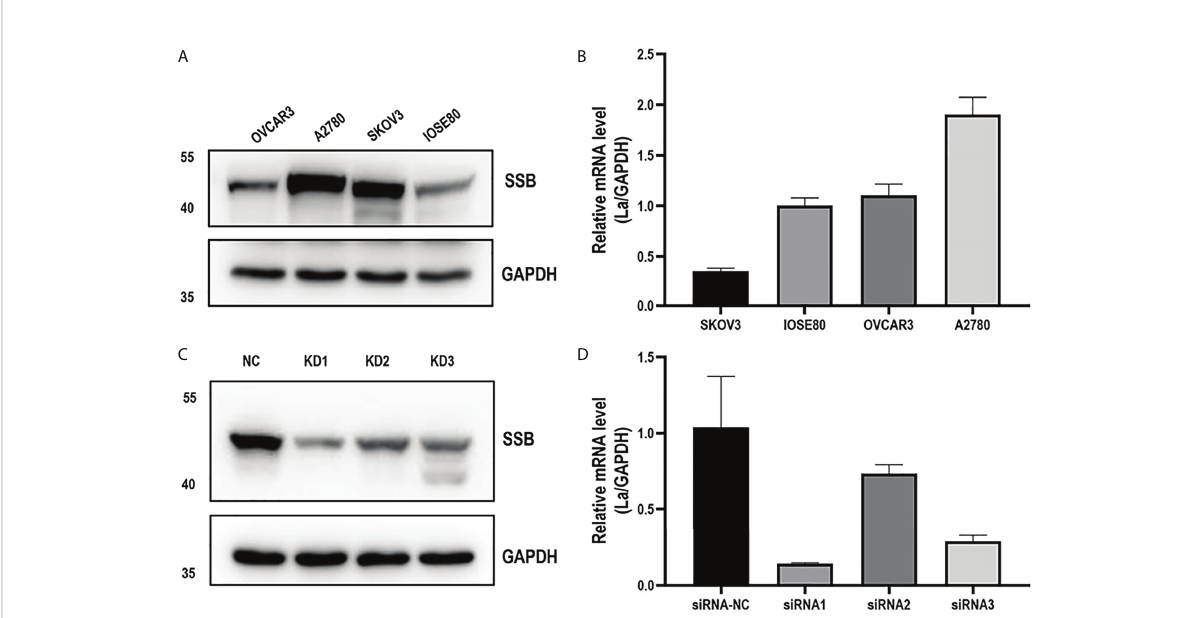
FIGURE 3 La mRNA level (A) and protein expression level (B) in ovarian cancer cells and human normal ovarian epithelial cells. The expression of La mRNA (C) and protein (D) in A2780 cells interfered by La lentivirus and control lentivirus. All data in the histogram are expressed as the mean ± standard deviation of three independent